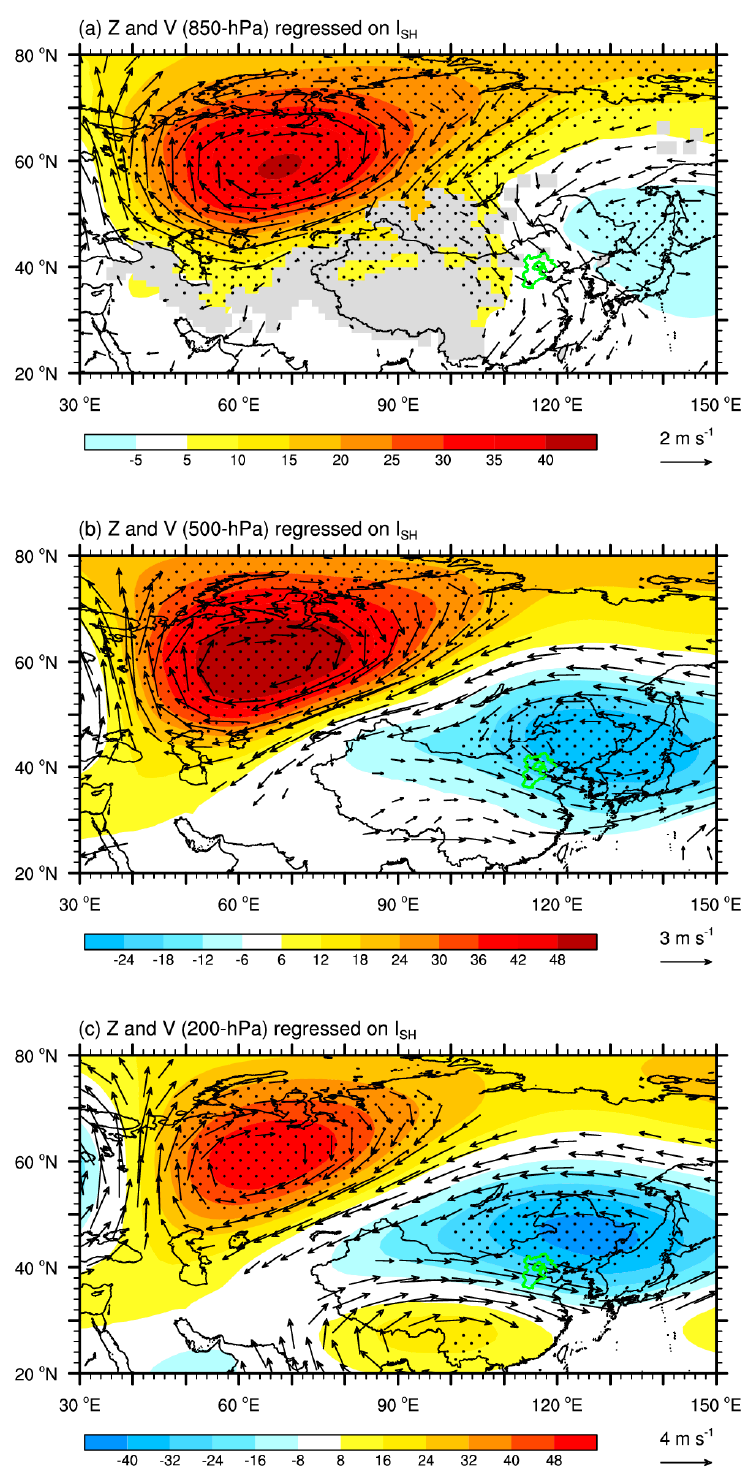
Figure 4. Regressions of I SH with the ( a ) 850 hPa, ( b ) 500 hPa and ( c ) 200 hPa geopotential height onto (shading, units: dgpm) and wind field (arrows, units: ms − 1 ). Regression coefficients exceeding the 95% confidence level are stippled. Only the vectors at the 95% confidence level or higher are shown. Green curve indicates the BTH region.